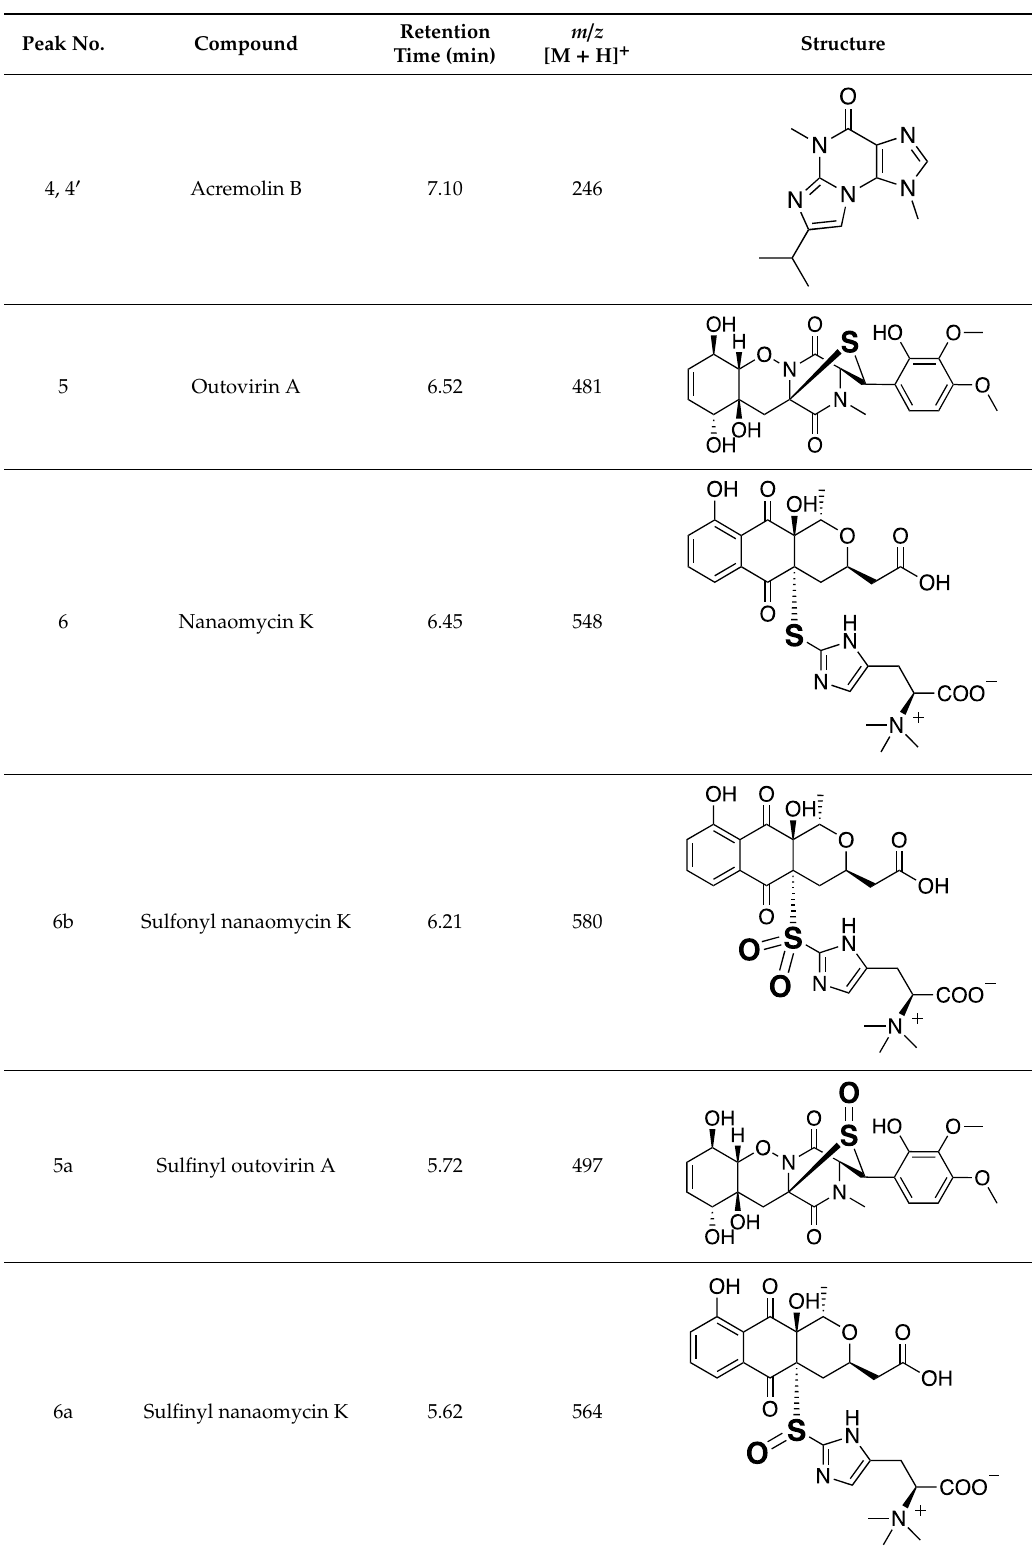
Table 1. The structures and LC/MS data of the compounds used in this study. Peak No.